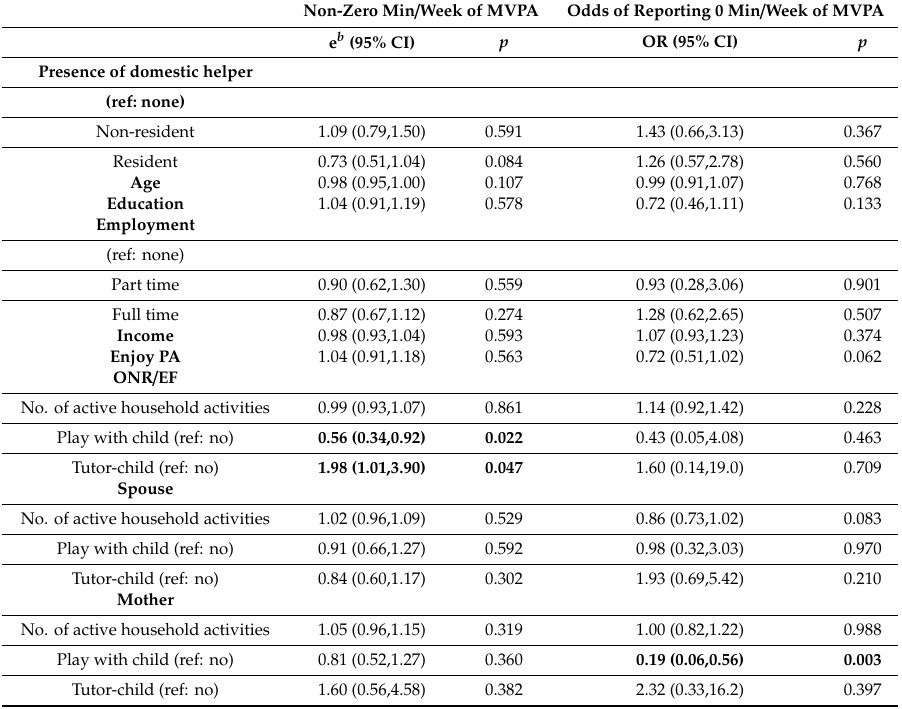
Figure 2. Direct and indirect effects of socioeconomic status on the mother’s moderate to vigorous physical activity. Table 6. Associations of mothers’ socio-economic status indicators and potential mediators with mothers’ moderate to vigorous physical activity (Step 4 of mediation analysis).